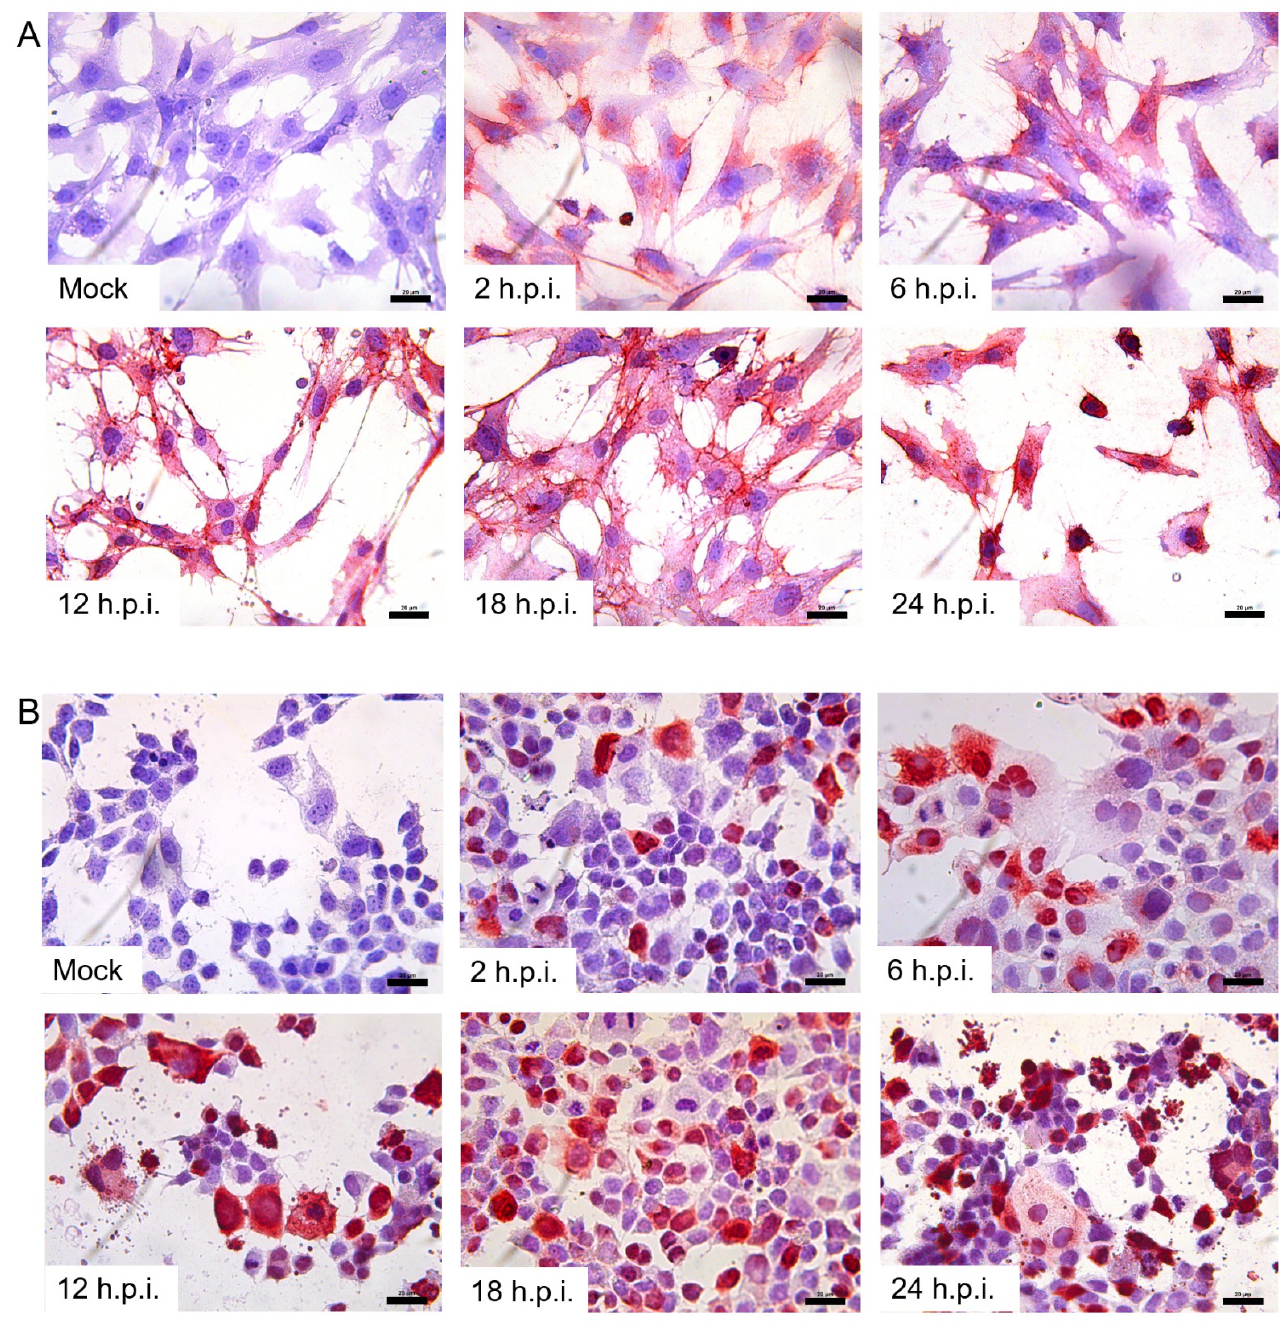
Figure 5. HA expression in H1N1/09-infected human placental cell lines. The brown–red color stands for the positive signals. An antibody against H1N1 HA was used to detect HA expression. TEV-1 cells ( A ) were mock-infected or infected with H1N1/09 for 2 h, 6 h, 12 h, 18 h and 24 h, respectively; JAR cells ( B ) were mock-infected or infected with H1N1/09 for 2 h, 6 h, 12 h, 18 h and 24 h, respectively. All cells were counterstained with hematoxylin. Scale bar = 20 μ m.